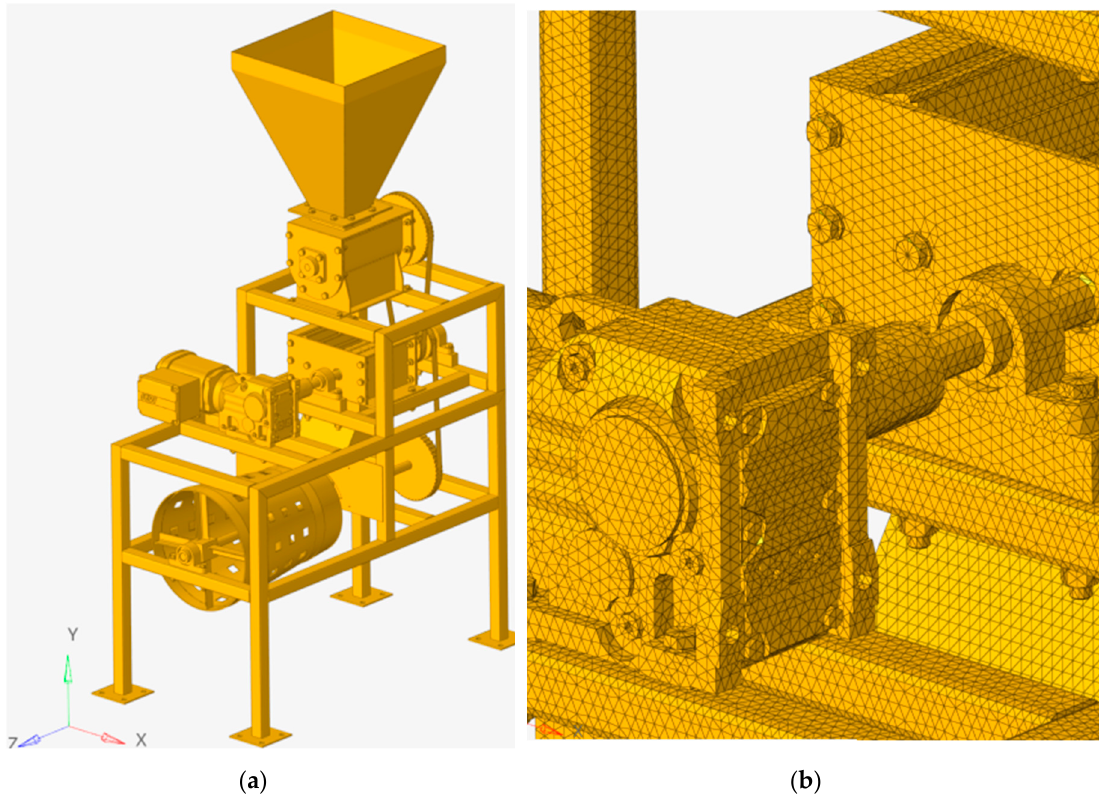
Figure 16. ( a ) Meshed shell craking machine model; ( b ) Mesh of the machine.